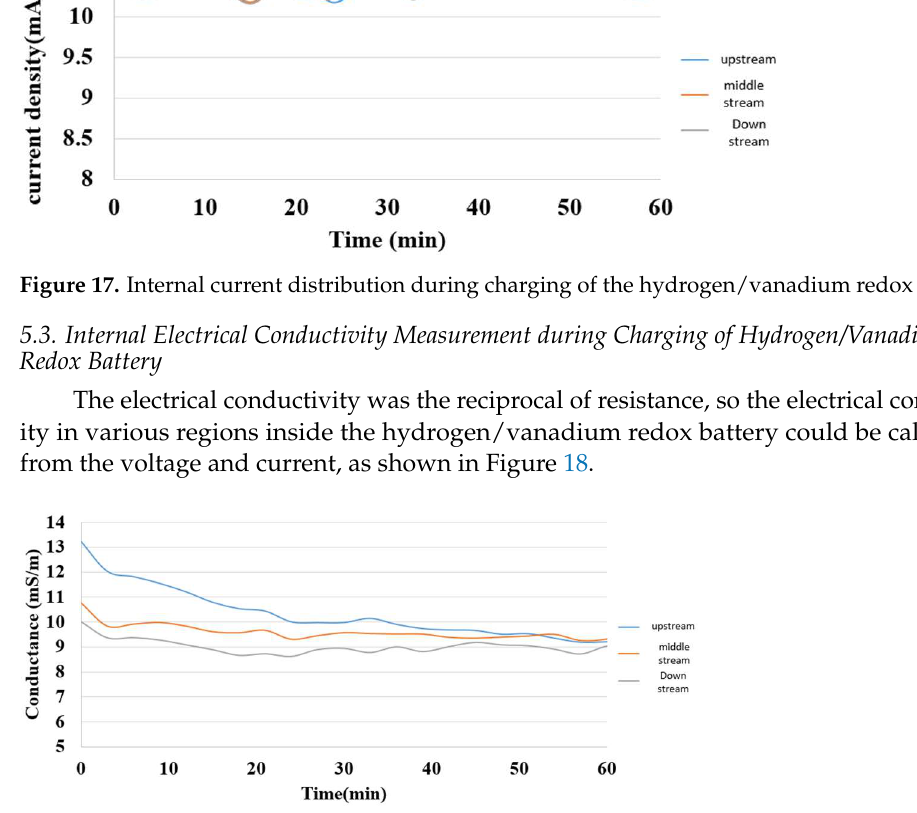
Figure 18. Internal electrical conductivity distribution during charging of the hydrogen/vanadium redox battery.